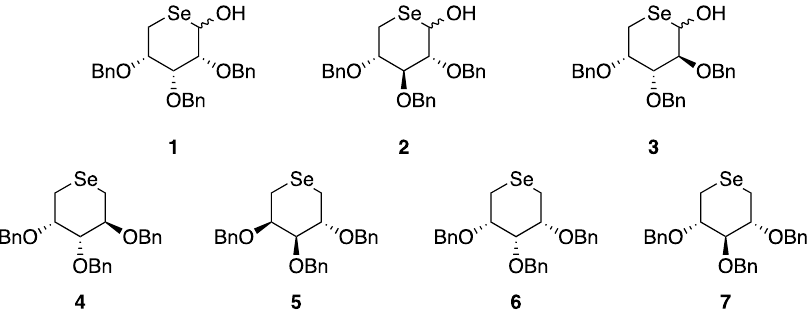
Figure 1. Structures of the 5-seleno-pentopyranose.